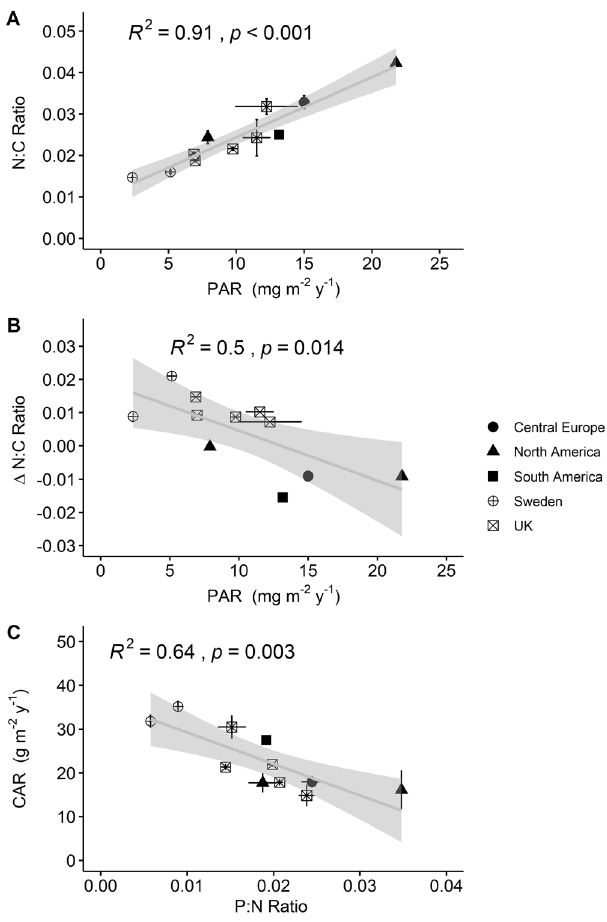
Fig. 4 Comparisons of catotelm P and C accumulation with catotelm stoichiometric indicators from eleven sites. A PAR in the catotelm is strongly correlated with the N:C ratio, interpreted as a decomposition proxy, across all sites. Each data point represents the mean value and error bars represent the standard error for catotelm peat at each dated site. B PAR in the catotelm is negatively correlated with the Δ N:C ratio, the difference between N:C in the acrotelm and catotelm. Lower Δ N:C indicates proportionally greater decomposition and loss of C as organic material moves through the acrotelm into the catotelm. C Sites that bury proportionally greater amounts of P relative to N are associated with slower C burial. PAR and NAR in isolation are only weakly correlated with CAR ( r 2 = 0.26 and 0.05, p > 0.1). Regression coef fi cients using acrotelm depths of 30 and 20 cm are extremely similar (Supplementary Table 4).